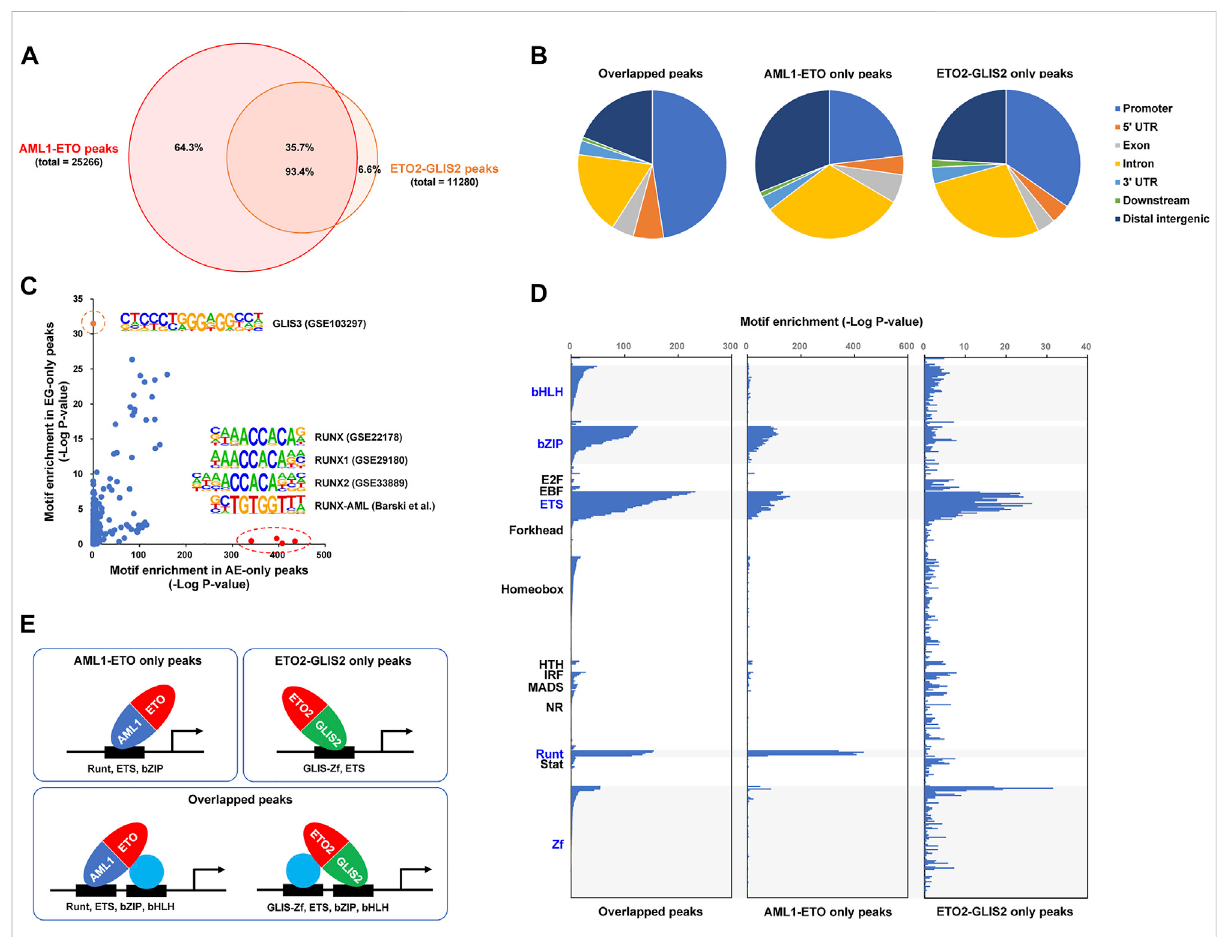
FIGURE 2 ChIP-seqanalysisofhowAML1-ETOandETO2-GLIS2bindtothegenome. (A) VenndiagramshowingtotalnumbersofthepeaksofAML1-ETO andETO2-GLIS2andtheiroverlap. (B) DistributionoftheoverlappedandAML1-ETOandETO2-GLIS2onlypeaksingenomicregionsrelatedtogene structural and regulatory elements. (C) Enrichment analysis of transcription factor binding site (TFBS) motifs in the AML1-ETO and ETO2-GLIS2 only peaks. Circled are 4 Runt motifs and a GLIS3 motif that are speci fi cally enriched in the AML1-ETO (AE) and ETO2-GLIS2 (EG) only peaks, respectively. (D) Comparison ofthe enriched TFBS motifs inthe3 classes ofpeaks.A total of440 motifs are analyzed, and theyare groups according totheirDNA-bindingdomains(DBDs)andalignedalongtheirenrichmentscore(minuslog10transformed p -value).Thehighlightedgroupsofmotifs arethoseenrichedinatleast1classofthepeaks. (E) Amodeldepicting that,while AML1-ETO andETO2-GLIS2canusetheirownDBDstobindDNA, they share large proportions of genome-wide binding regions dependent on the indicated cooperative transcription